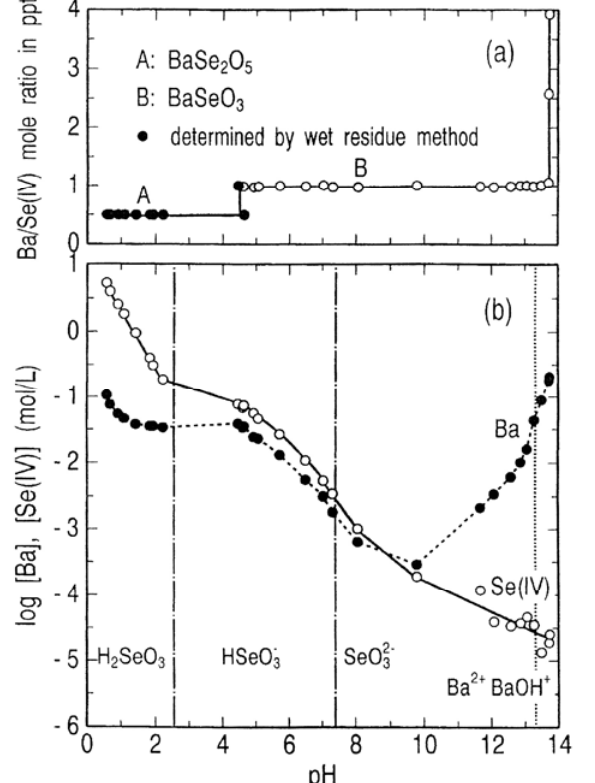
Figure 9. Ternary phase diagram for the BaO-SeO